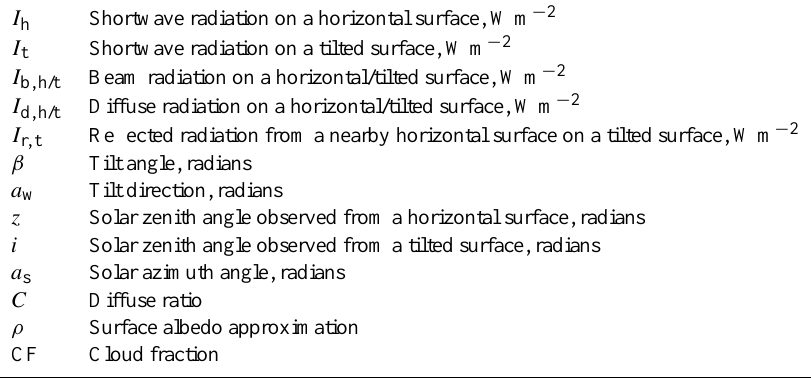
Table A1. Variables used in Sect.